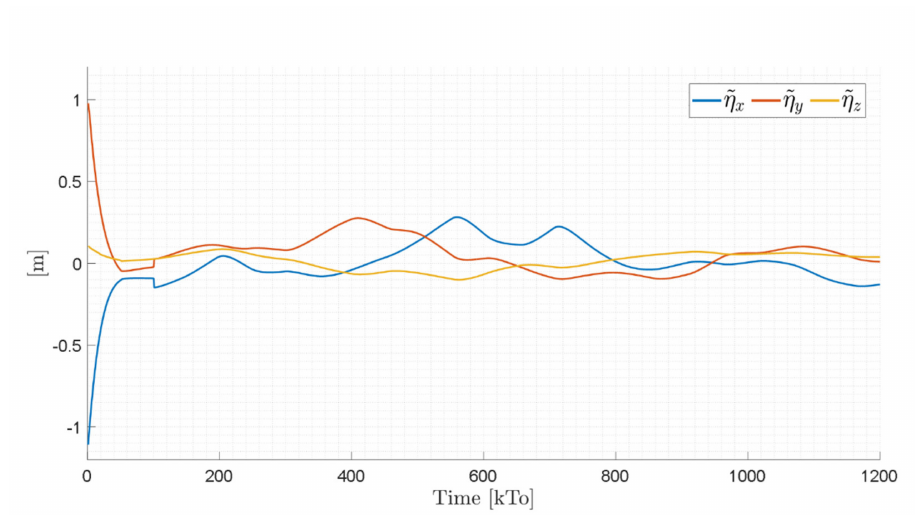
Figure 29. Time evolution of the control errors ˜ η ( kT 0 ) = ( ˜ η x , ˜ η y , ˜ η z ).